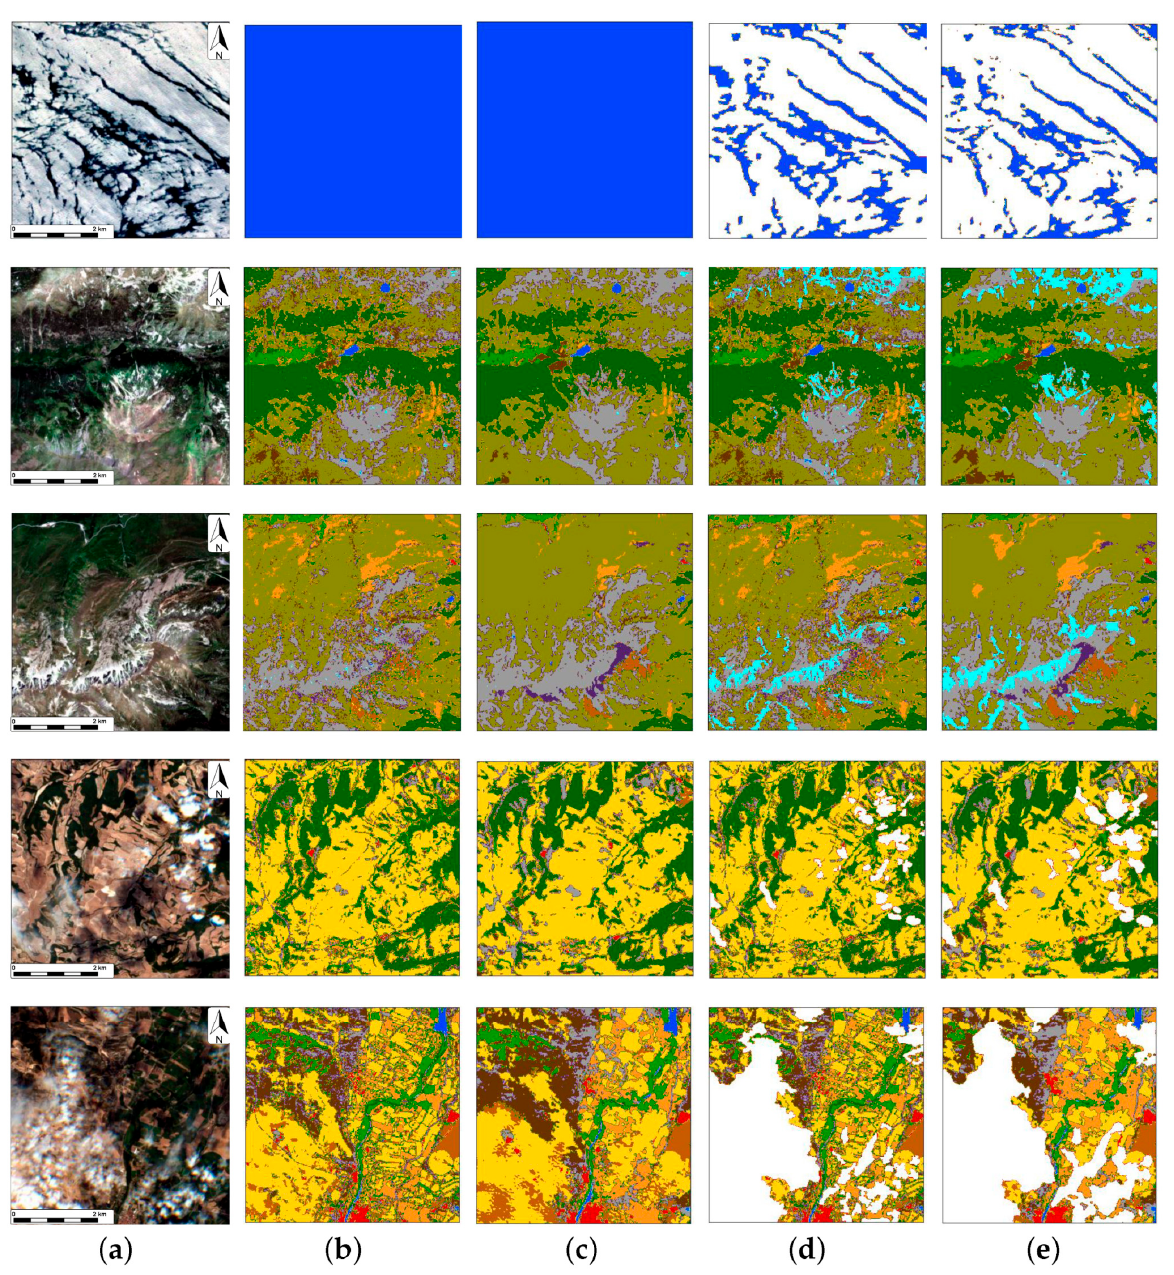
Figure 10. Samples of S2GLC 2017-Cat dataset after relabeling: ( a ) Sentinel-2 image, ( b ) original GT map, ( c ) SSSR results obtained with the original GT maps, ( d ) GT map after relabeling, ( e ) SSSR results obtained after training the model with the relabeled